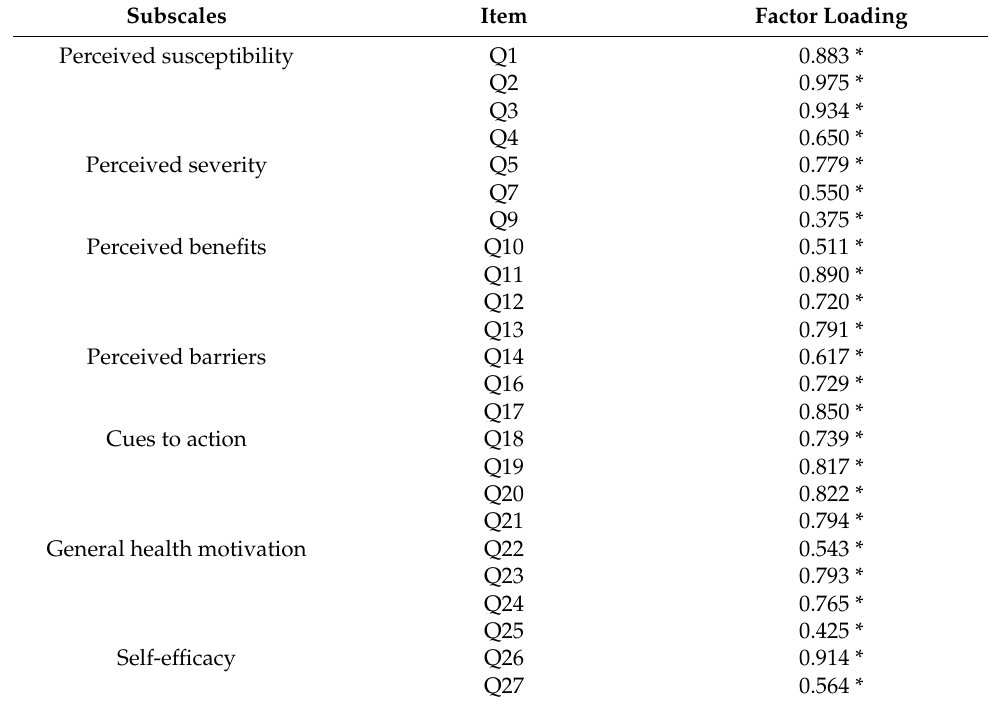
Table 5. Confirmatory Factor Analysis report. Subscales Item Factor